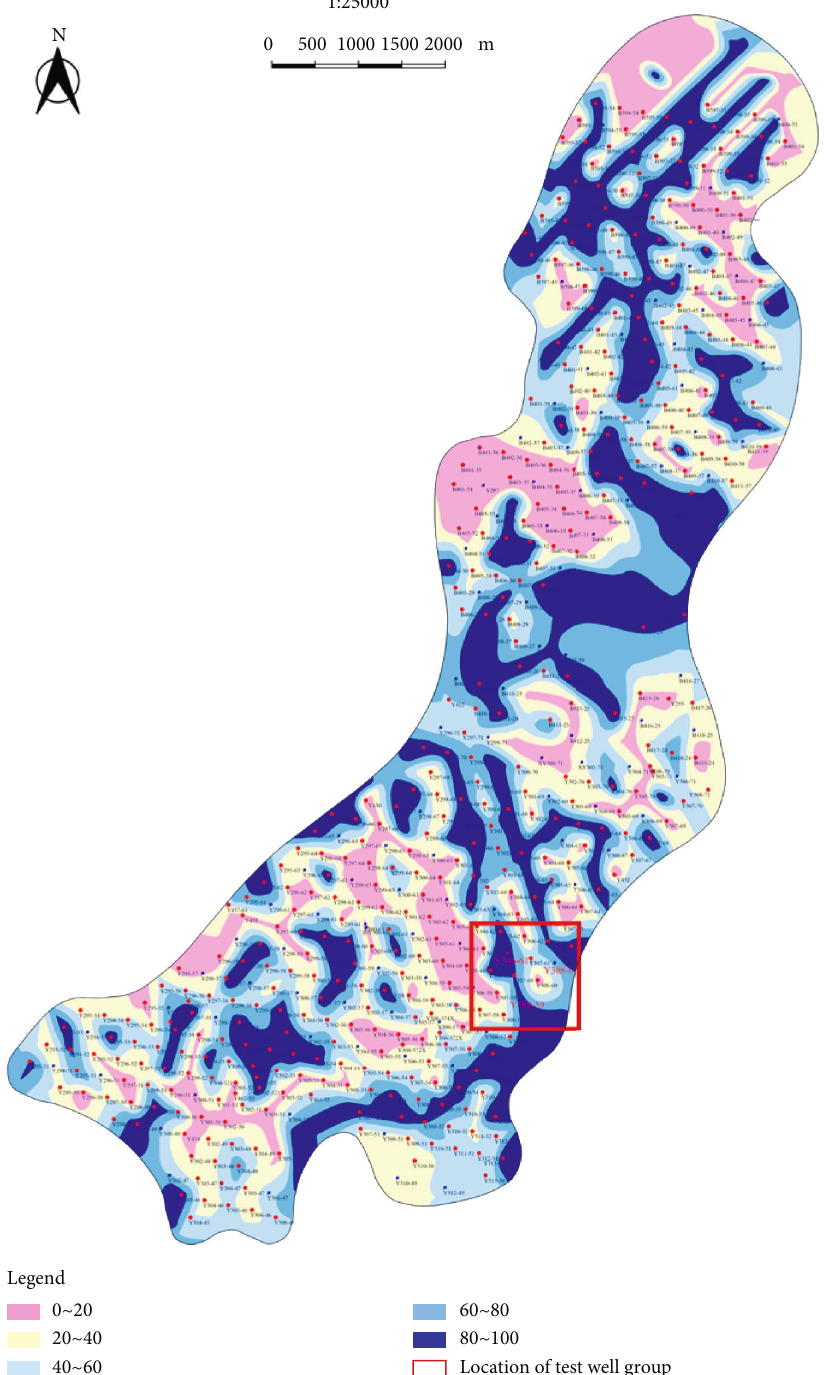
Figure 3: Water cut distribution in Y 284 area of Chang 6 reservoir in the Huaqing area. Table 1: Fracture characteristics and realization di ffi culty of volume fracturing under di ff erent two-dimensional horizontal principal stress di ff erence. - σ ( σ H h